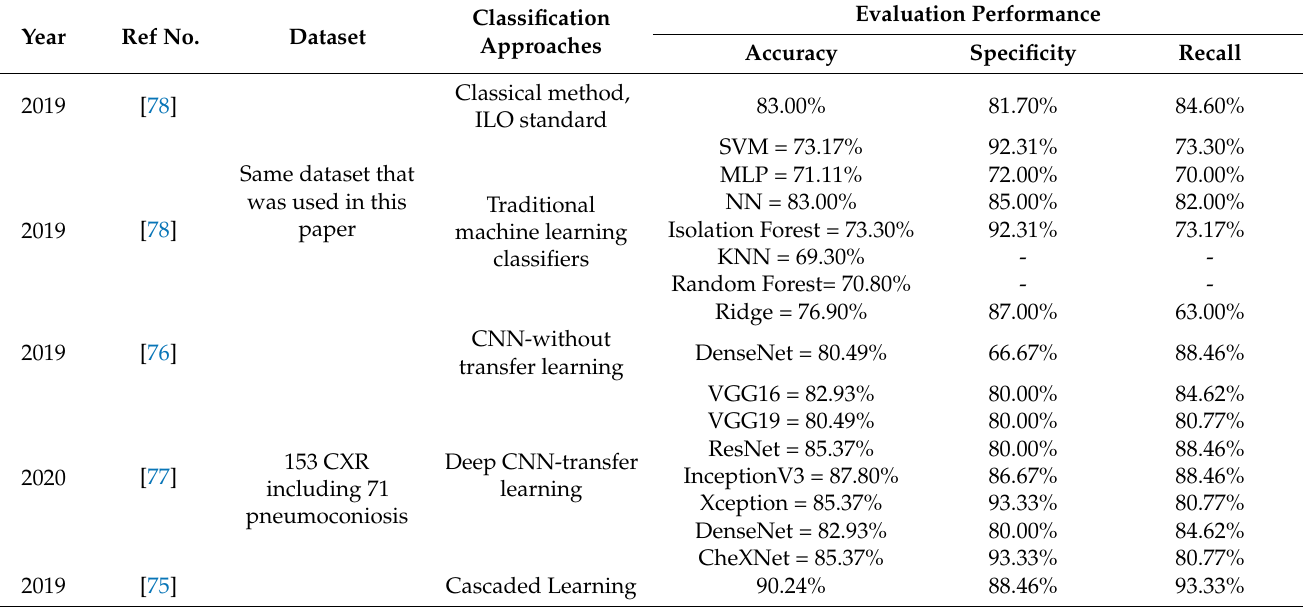
Table 1. Summary of all classical, traditional, and deep learning approaches previously performed on the same